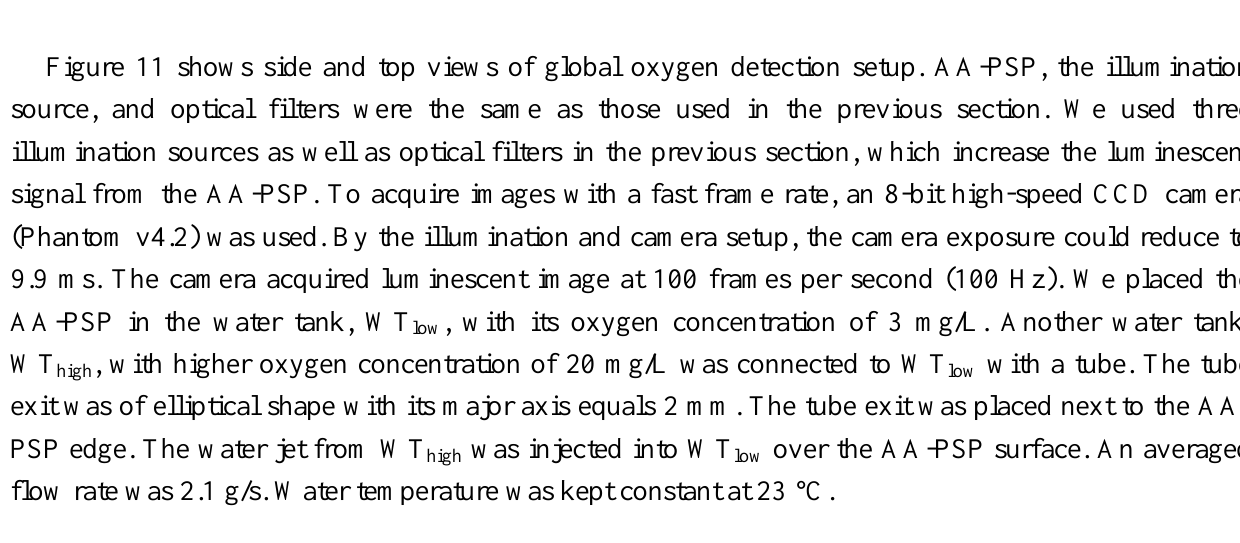
Figure 11. Side and top views of oxygen water impingement